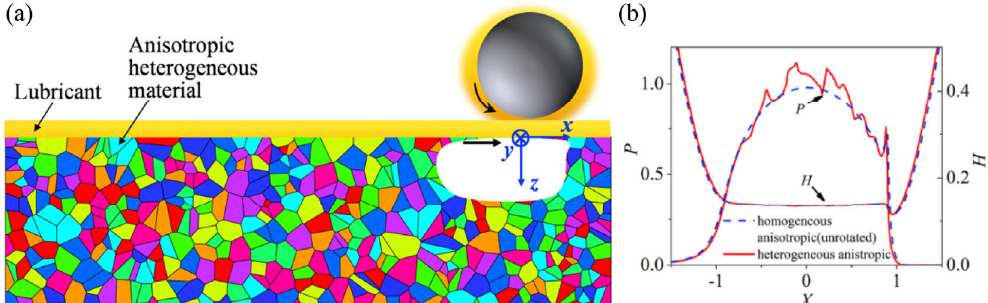
Fig. 53 Schematic representation of (a) an elastohydrodynamically lubricated contact between a sphere and a polycrystalline anisotropic material and (b) comparison between isotropic and anisotropic materials [856]. Reproduced with permission from Ref.